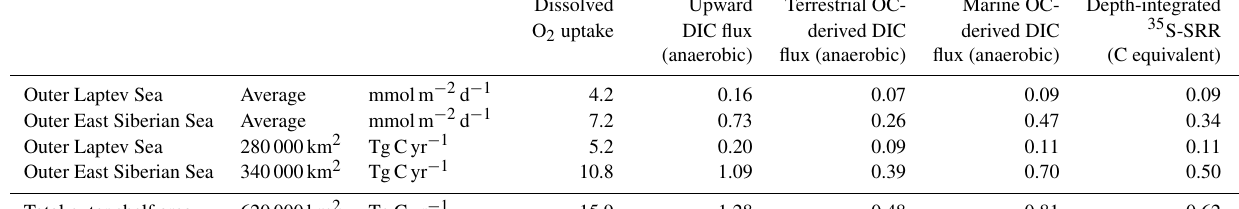
Figure 9. (a) Water depth variation in sediment oxygen uptake. (b) Water depth variation in integrated 35 S-sulfate reduction rates (0–30cm sediment depth). For reference average rates of abyssal plain, continental rise, slope, and shelf sediments, depositional and non-depositional shelf sediments are shown for reference. Table 5. Regional estimates of sediment carbon mineralization in the outer Laptev and East Siberian sea shelf. Dissolved